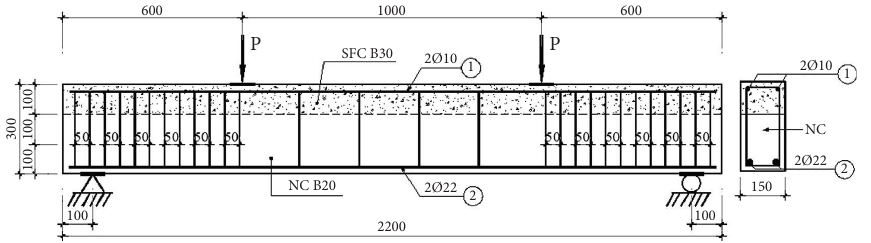
Figure 1: In the design, a double-layer concrete beam model is used.